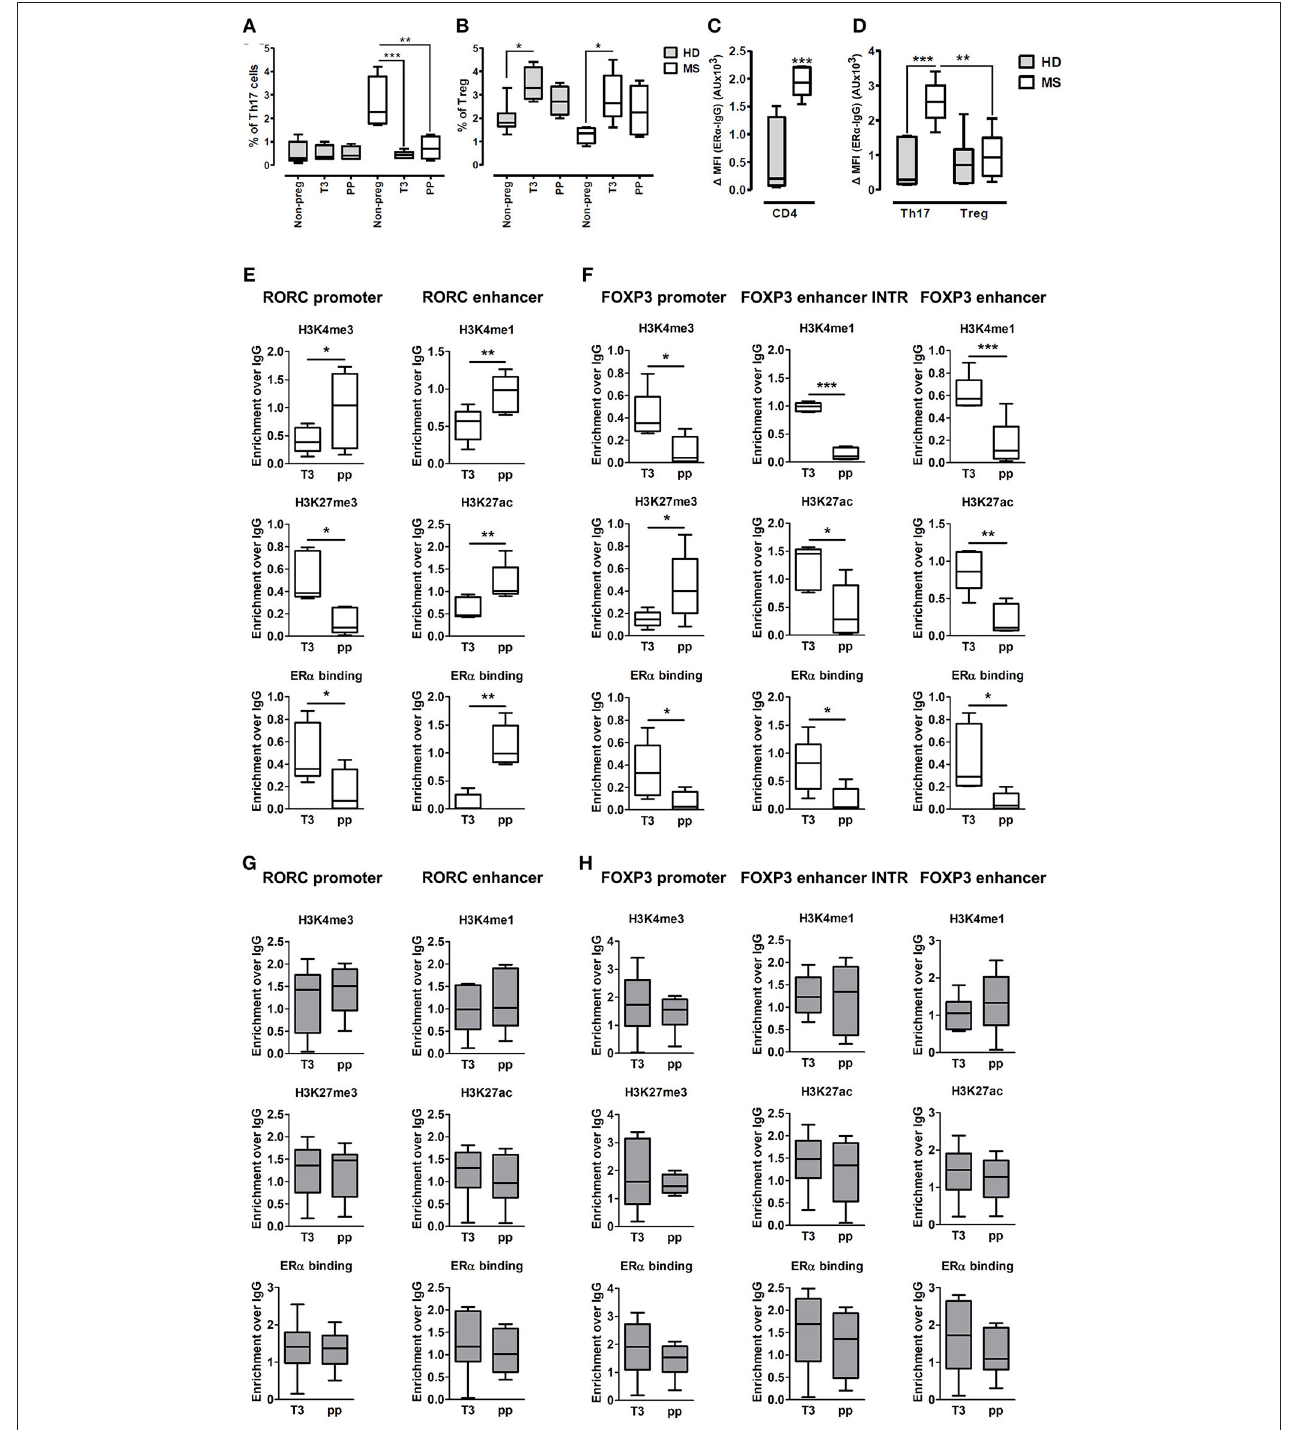
FIGURE 4 | Epigenetic changes at FOXP3 and RORC loci in PBMCs from MS patients during pregnancy. (A,B) Th17 and Treg cells percentage, evaluated by FACS, in the PBMCs of HD (gray bars) and MS patients (white bar) non-pregnant, during the T3 and in the pp. (C,D) Expression of ER α , evaluated by FACS, on total CD4 + T cells, Th17, and Treg cells from HD and MS patients. Graph shows ER α specific cell-associated mean fluorescence ( 1 MFI). (E–H) ChIP-qPCR analysis of H3K4me3, H3K27me3, H3K4me1, H3K27ac, and ER α binding on PBMCs derived from MS patients (E,F) and HD (G,H) during T3 and in the pp. Boxes, with mean, minimum and maximum, represent the enrichment of the immunoprecipitation over non-specific IgG and normalized for input chromatin. * p < 0.05, ** p < 0.01 and *** p < 0.001 represent the statistical significance.